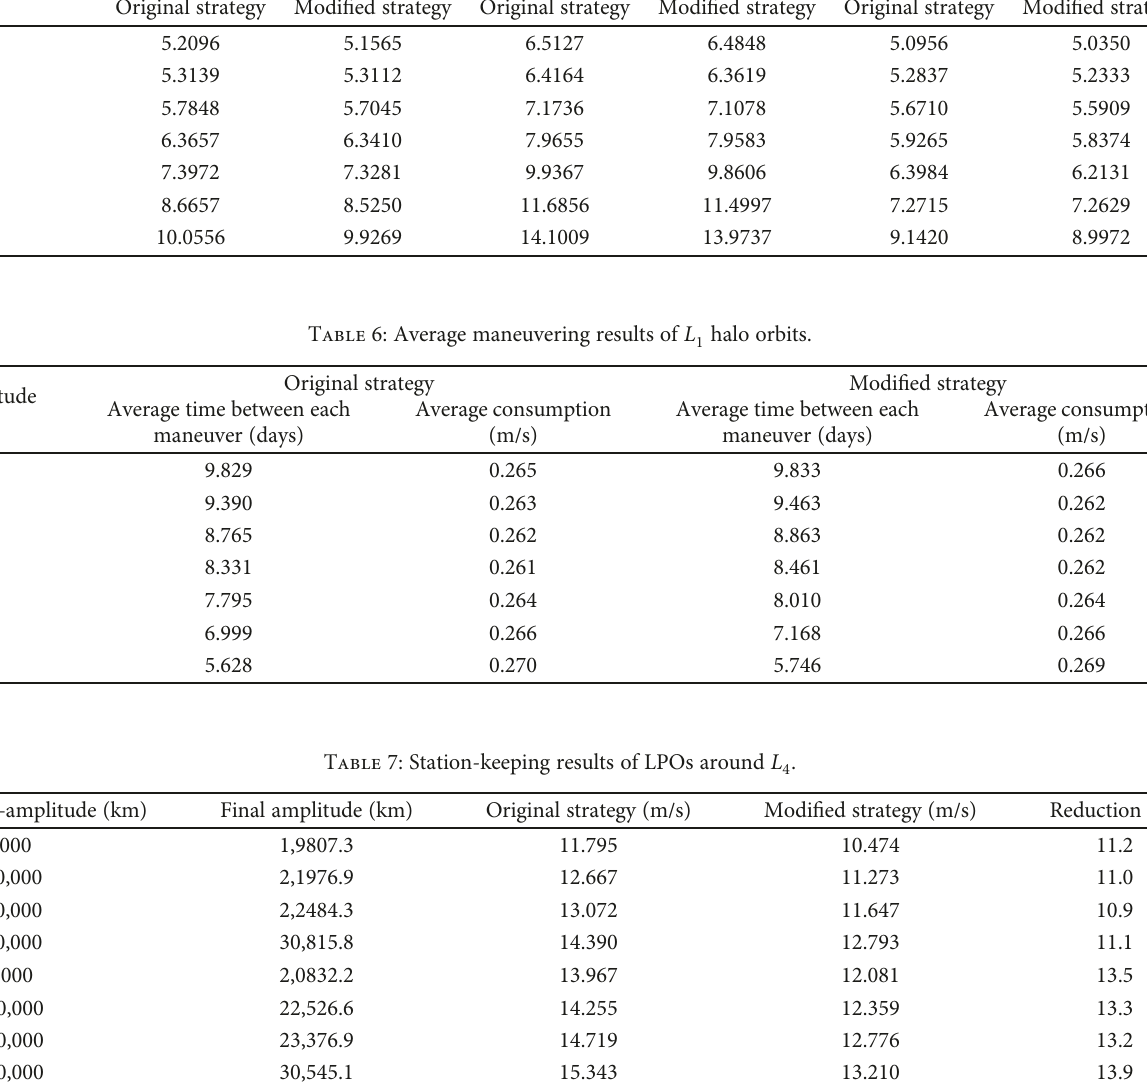
Table 5: Station-keeping results of LPOs around L